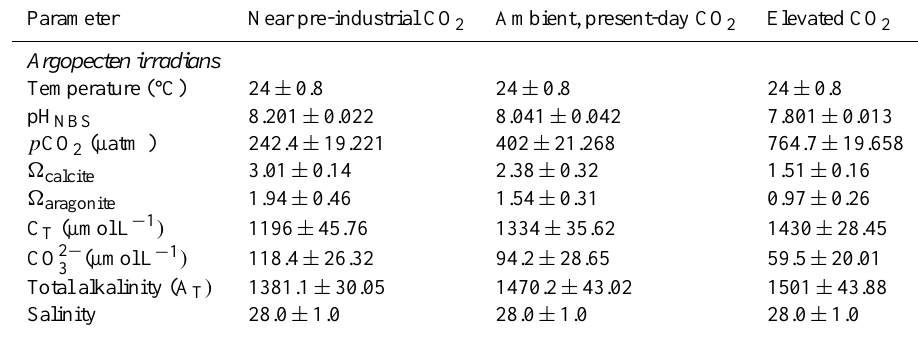
Table 2. Mean temperature, pH, carbonate chemistry, total alkalinity, and salinity (±1SD) during the three-level carbon dioxide for calcium uptake over time for Argopecten irradians